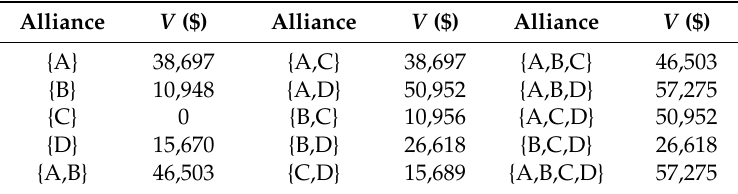
Table 5. Peaking Compensation of Each Alliance.